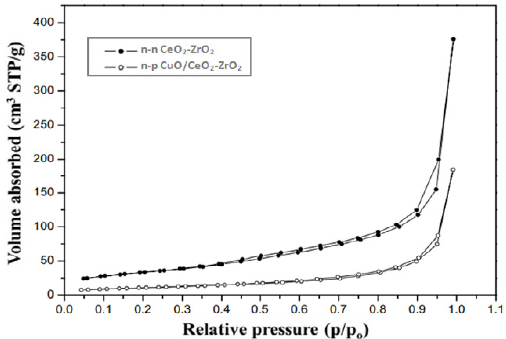
Fig.5. N adsorption-desorption isotherms of n-CeO 2